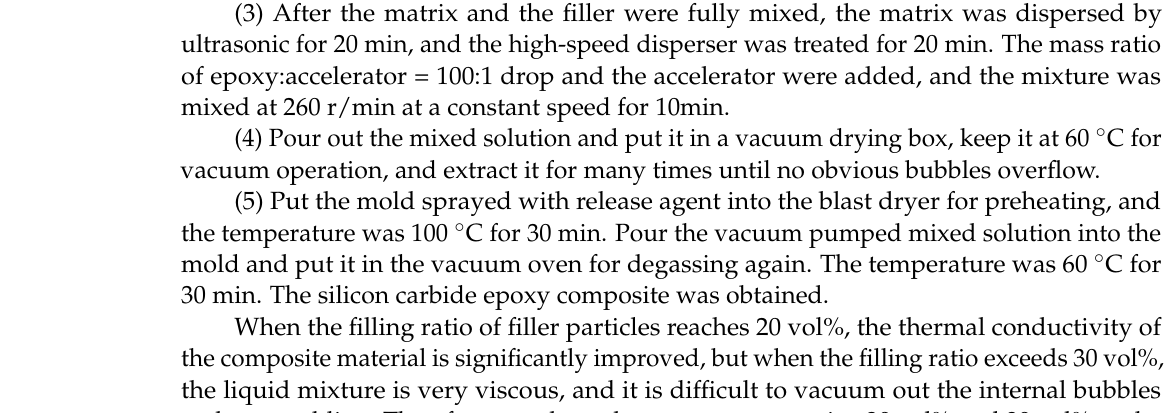
Figure 1. Epoxy composite preparation process.